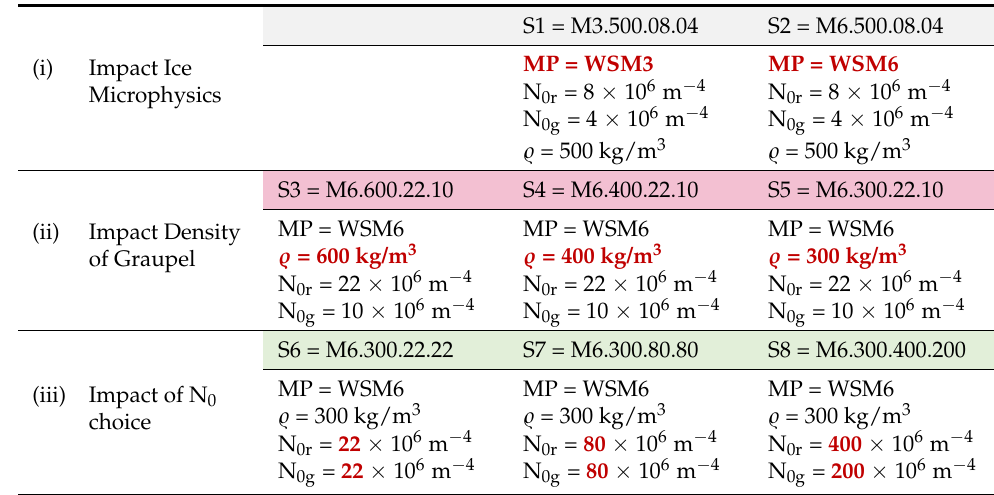
Table 1. Summary of the selected values for the assumed characteristics of the hydrometeors, for each of the sensitivity tests. Note: for each set of tests, the parameter values that are being changed are marked in bold and in red. MP is used to designate the microphysical scheme used in the simulation. Each of the experiments is designated by the sensitivity to: (i) the choice of MP; (ii) the assumed density of the large ice particles ( (cid:36) ); (iii) the intercept parameters for the rain (N 0r ) and graupel (N 0g ). In that sense M6.500.08.04 means the experiment using MP = WSM6, (cid:36) = 500 kg/m 3